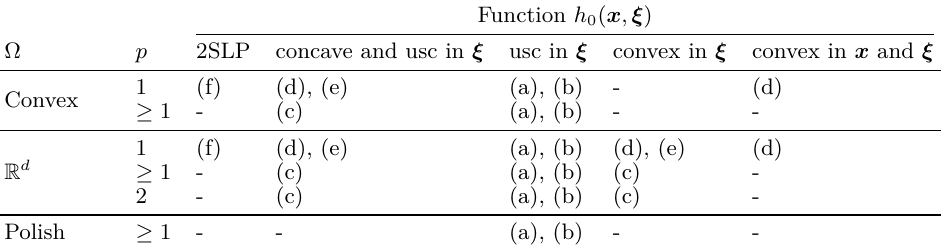
Table 1 Duality and reformulation contributions for p -Wasserstein-based ambiguity sets. “usc” stands for upper semicontinuous and “2SLP” stands for a two-stage stochastic LP, i.e., (3) with q 1 = 0. Note that a 2SLP with stochasticity on the right-hand side or objective is a special case of function h 0 ( x , ξ ) that is convex or concave in ξ ,